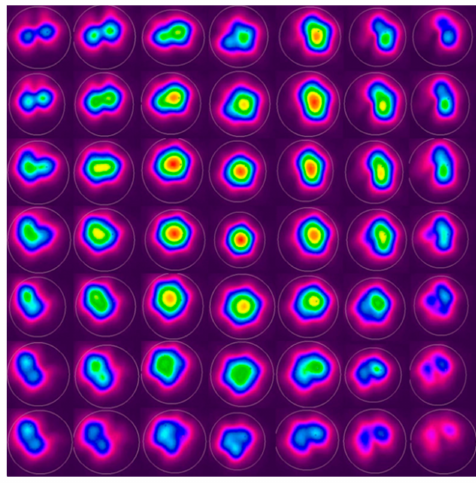
Figure 3. Transmitted mode content under varying coupling conditions of a hollow core